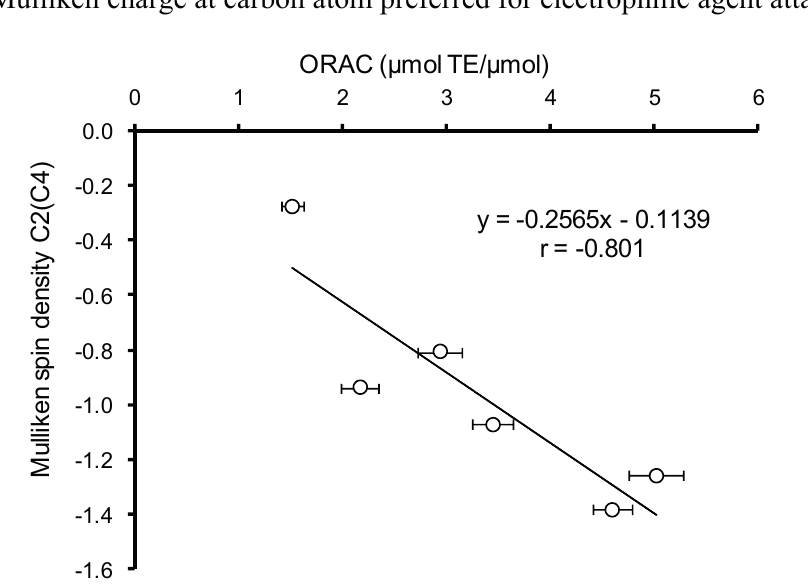
Figure 5. Correlation analysis between AOC of hydroxyaromatic acids against peroxyl radical and Mulliken charge at carbon atom preferred for electrophilic agent attacks.